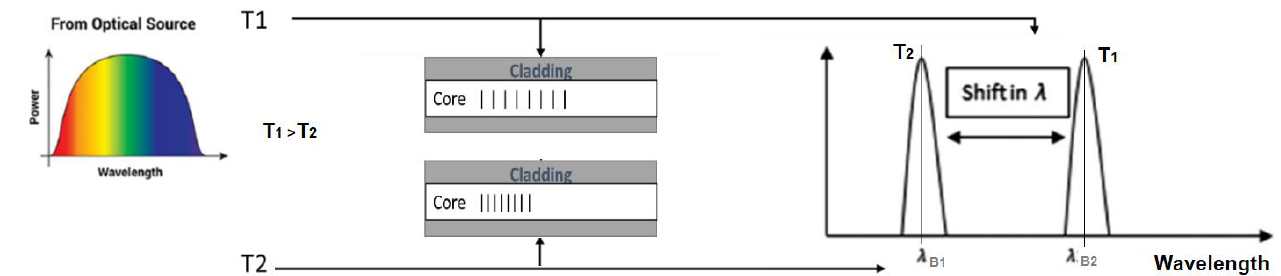
Figure 1. An example of changing temperature and equivalent change in the Bragg wavelength of FBG [18].